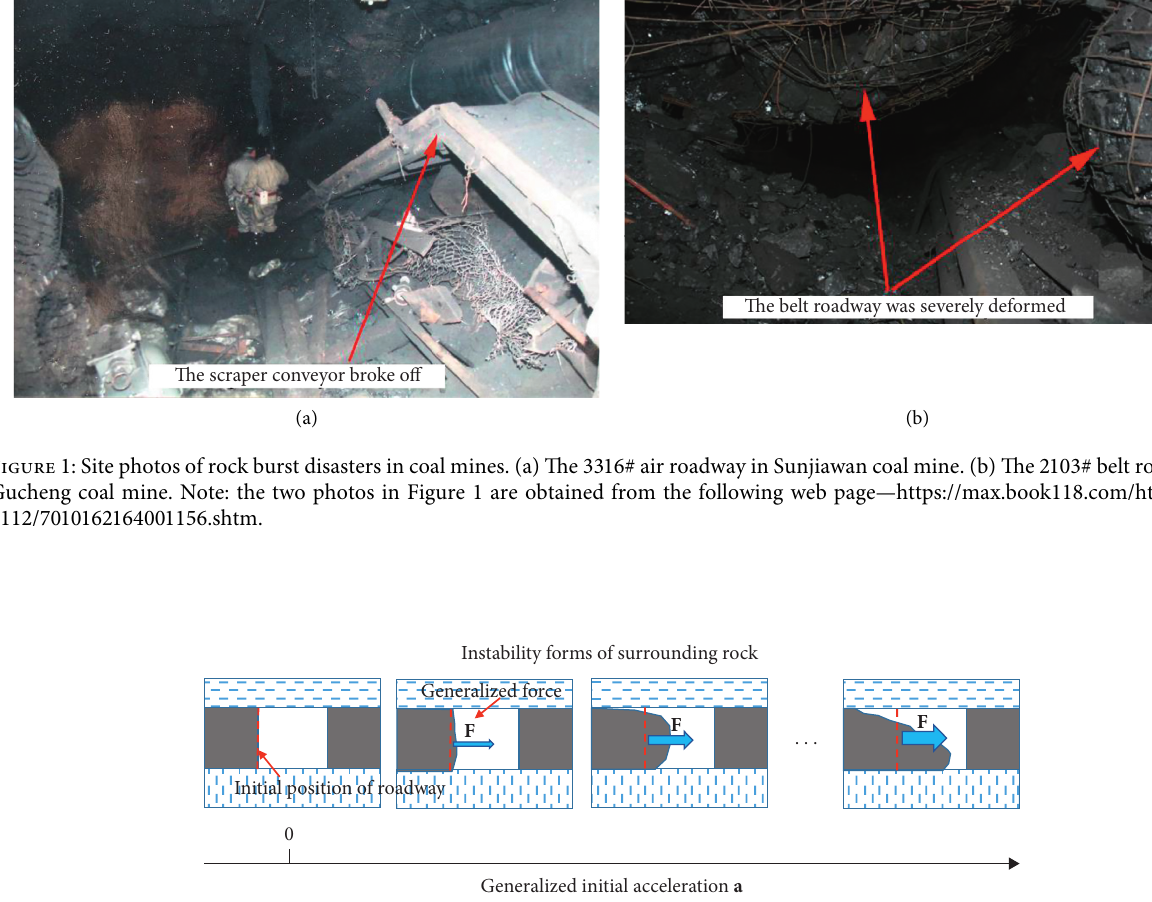
Figure 2: Schematic of the relation between generalized initial acceleration of surrounding rock and its instability form.